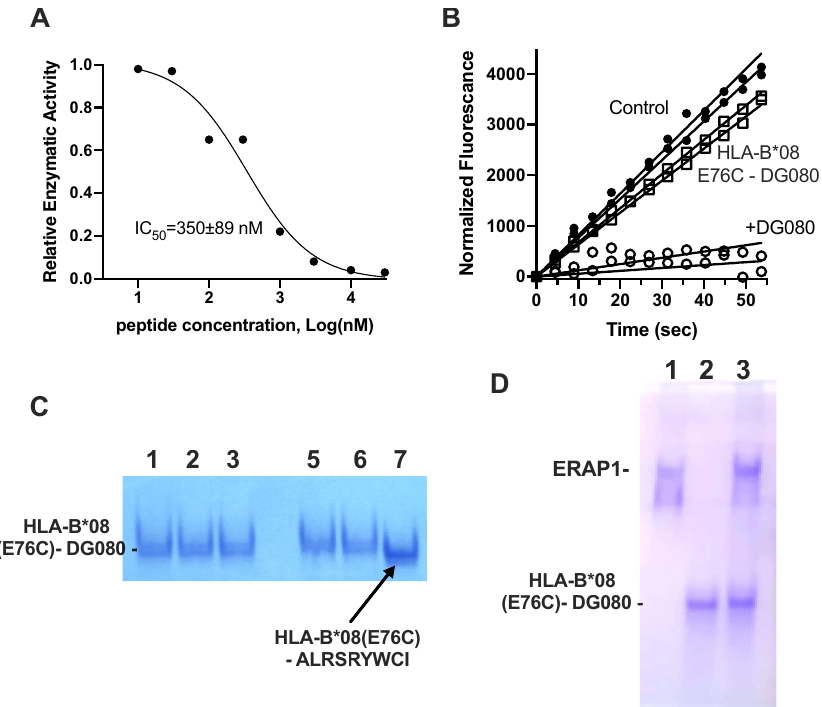
Figure 4. Characterization of the interaction between DG080 and the active site of ERAP1. Panel ( A ) effect of titration of free DG080 peptide on ERAP1 enzymatic activity (each point is the average of two measurements). Panel ( B ) time-dependent hydrolysis of fluorigenic ERAP1 substrate in the presence of 1 μΜ of either free DG080 or HLA-B*08 (E76C)-DG080 complex (two measurements per condition are shown). Panel ( C ) native- PAGE analysis of the stability of HLA-B*08(E76C)-DG080 complex: lane 1 , complex incubated at 4 °C for 1 h; lane 2 , complex incubated at 37 °C for 1 h; lane 3 , complex incubated at 37 °C for 1 h in the presence of 20 nM ERAP1; lane 5 , complex incubated at 37 °C for 1 h; lane 6 , complex incubated at 37 °C for 1 h in the presence of 100 μM of peptide ALRSRYWAI; lane 7 , HLA-B*08 (E76C)-ALRSRYWCI complex (full-length gel is presented in Supplementary Fig. 2). Panel ( D ) Native-PAGE of ERAP1 and HLA-B*08 (E76C)-DG080 complex: lane 1 , ERAP1; lane 2 , HLA-B*08 (E76C)-DG080 complex; lane 3 , equimolar mixture of ERAP1 and HLA-B*08